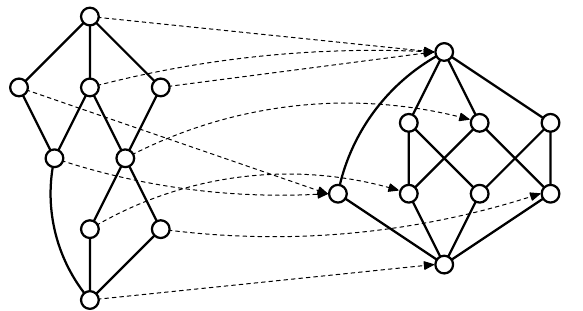
Figure 3. The (cid:87) -preserving mapping f γ corresponding to the bond γ from Example